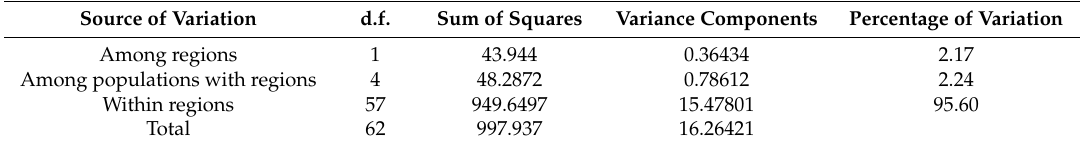
Figure 2. Population genetic structure analyses of 64 Argyresthia conjugella individuals using STRUCTURE. The insects are sorted according to Id number as in Supplementary Table S1 (W: Norway: Western region, E: Norway: Eastern region and S: Sweden). Table 4. Analysis of molecular variance (AMOVA) of Argyresthia conjugella among the three sampling regions using 259